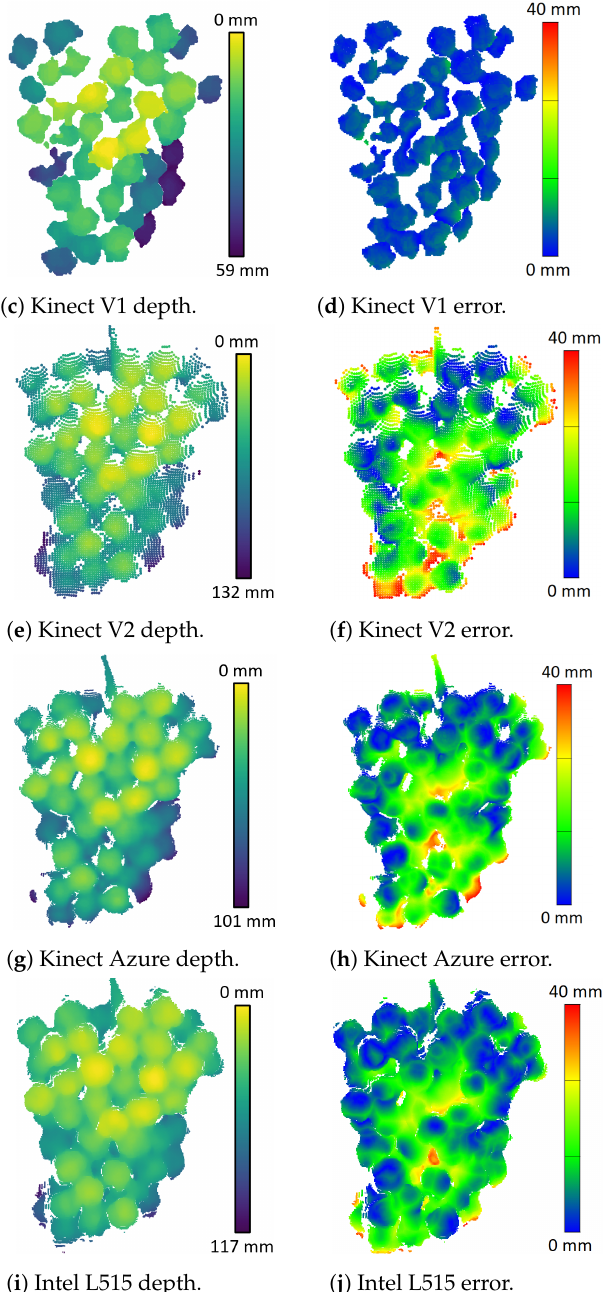
Figure 7. Depth and error scans (relative to the photogrammetry scans) for the RGB-D cameras located indoors at a distance of 600 mm from the unpainted grape bunch. An error bar is provided that shows the colour scale for the error scans and is the same for all the cameras. The colours for the depth scans are relative to the maximum and minimum depth of the point cloud for each